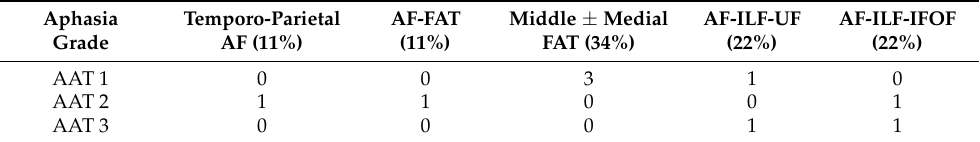
Table 3. Grade of postoperative speech deficits.